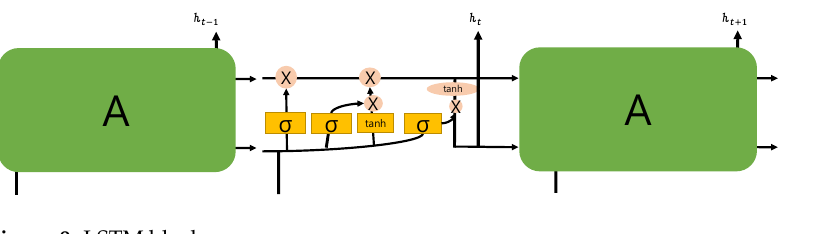
Figure 9. LSTM block.